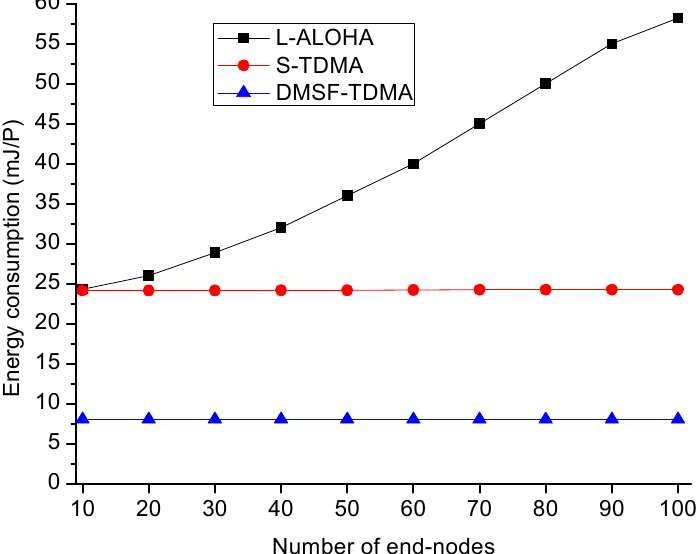
Figure 18. Average delay with a different number of end-nodes.